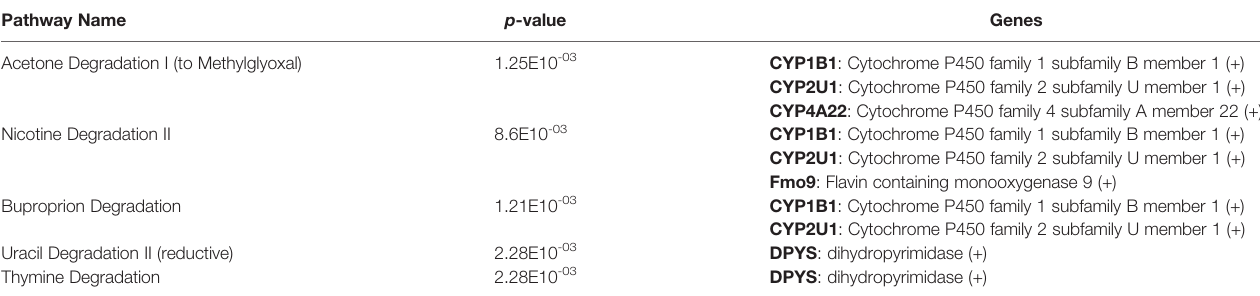
TABLE 2 | C. neoformans leads to the activation of highly speci fi c metabolic pathways in male CD11b + permissive DCs. Pathway Name